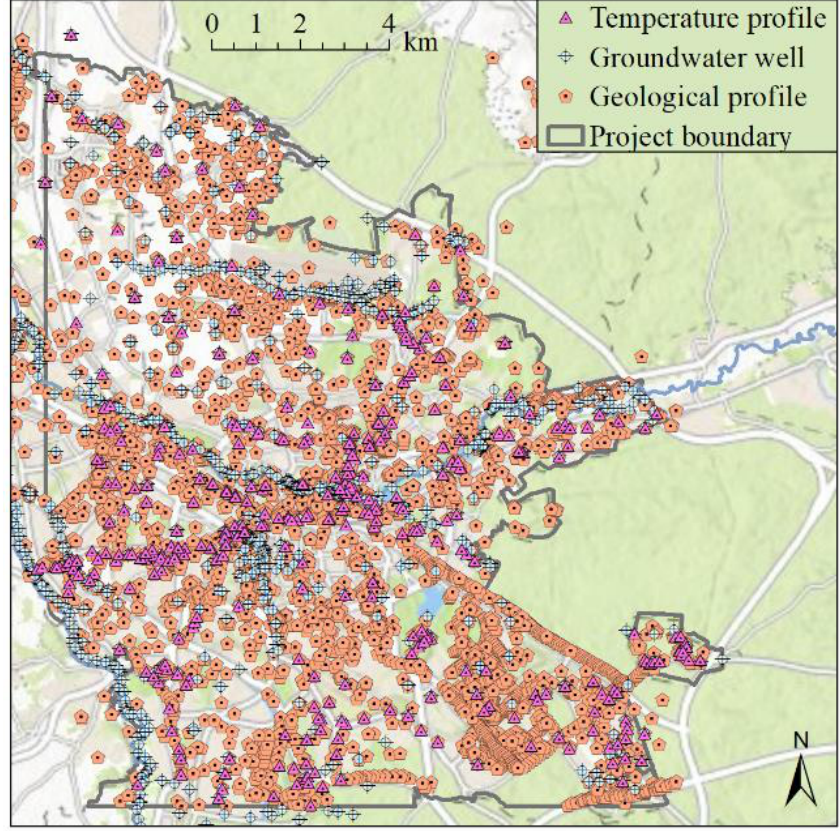
Figure 4. Spatial distribution of the boreholes and wells with for temperature profiles, the distance to groundwater, and the geological model, Sources: Esri, HERE, DeLorme, increment P Corp., NPS, NRCan, Ordnance Survey, © OpenStreetMap contributors, USGS, NGA, NASA, CGIAR, N Robinson, NCEAS, NLS, OS, NMA, Geodatastyrelsen, Rijkswaterstaat, GSA, Geoland, FEMA, Intermap and the GIS user community.